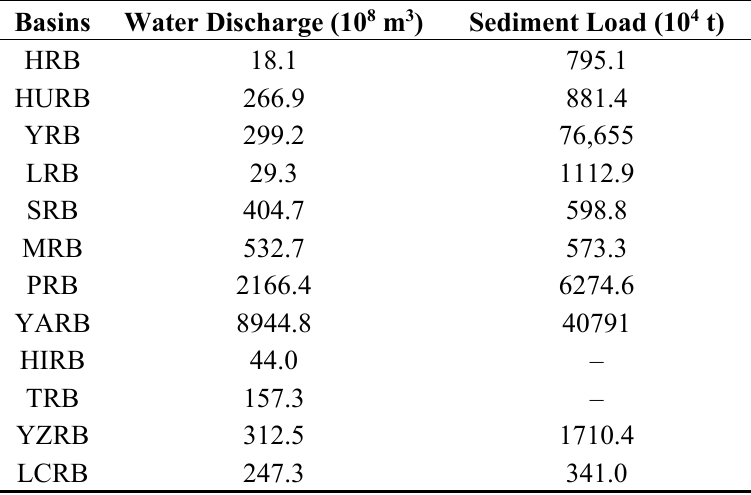
Table 2. Average annual streamflow and sediment load.